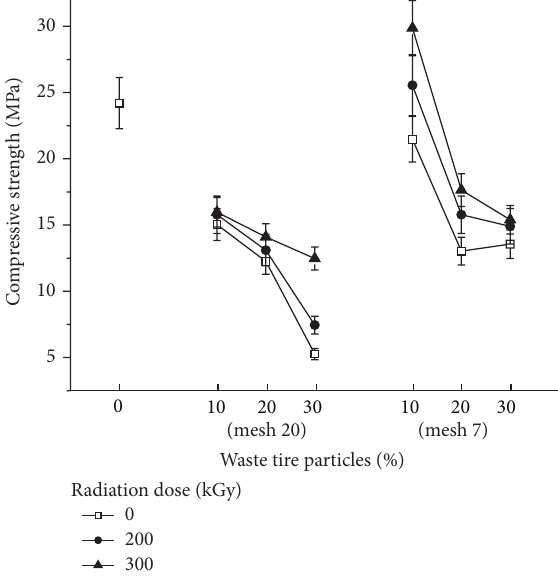
Figure 2: Compressive strength of concrete with waste tire particles 0.85 mm (mesh 20) and 2.8 mm (mesh